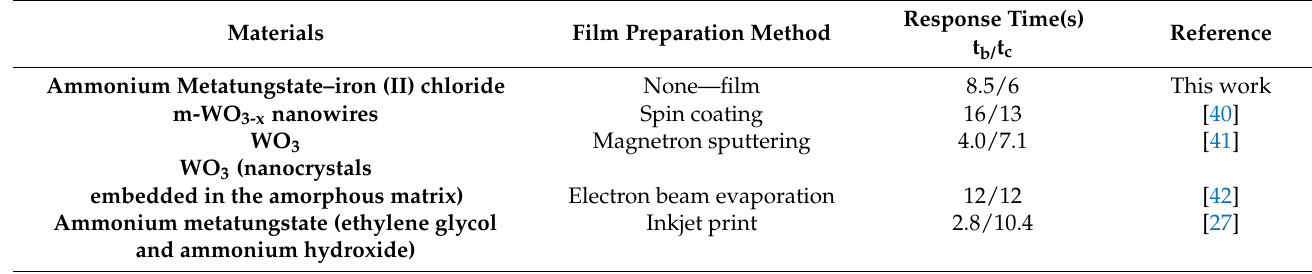
Figure 7. The mean main effect diagrams of different factors for the response time: ( a ) ammonium metatungstate; ( b ) current density; ( c ) iron (II) chloride. Table 3. Comparison of electrochromic (EC) materials, film preparation methods, and response time (t c , t b ) between the literature and this work.